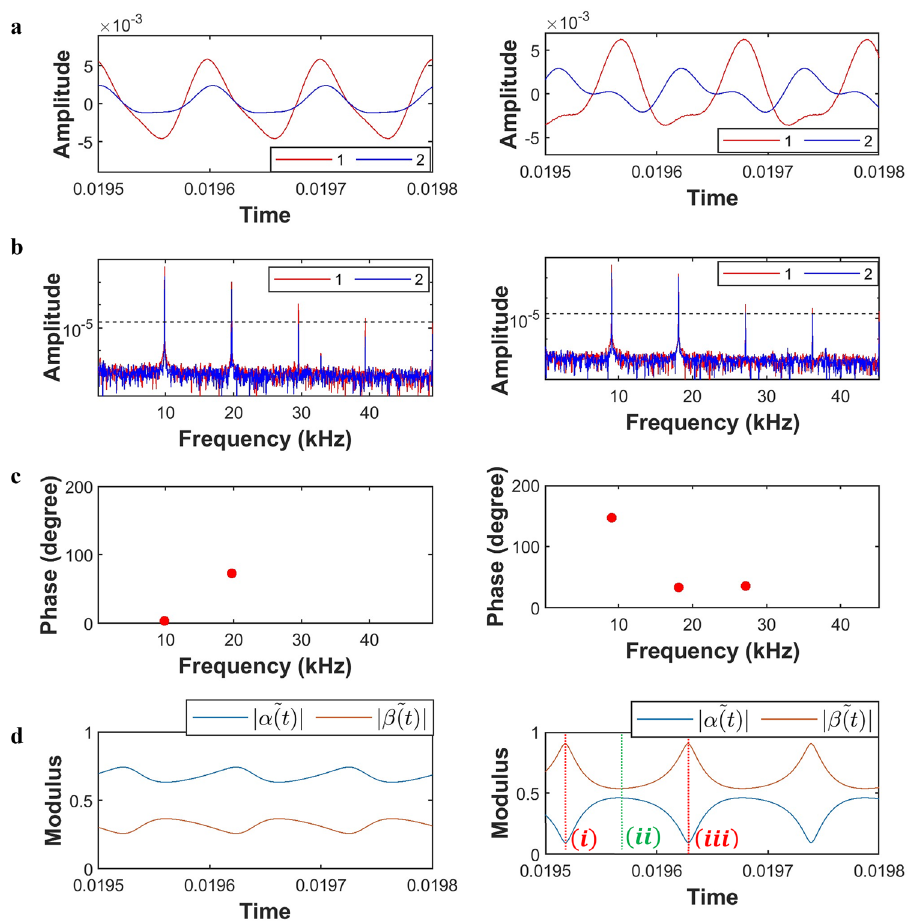
Figure 1. Measurement and tunability of classical analogue to superposition of states. (a) Amplitude versus time recorded by the detecting transducers of each granule at steady state, revealing rich nonlinear responses of 9.85kHz and driving amplitude 100 V the system. Left panel: driving frequency ω D p p ; Right panel: driving = − 9.05kHz and driving amplitude 100 V frequency ω D p p . (b) Temporal Fourier transform of the granules = − amplitudes, and (c) phase differences between granules; revealing the combinations of E 1 and E 2 eigenstates associated with each characteristic frequency. In (b), the dashed horizontal line indicates the amplitude threshold for the selection of dominant characteristic frequencies. (d) Time evolution of the modules of the β( t ) , of two mutually orthogonal states α( t ) and E 1 E 2 complex amplitudes, and . In (d), the vertical lines | | � � labeled (i), (ii), and (iii) correspond to three different time instants: ( i (cid:31) (cid:31)